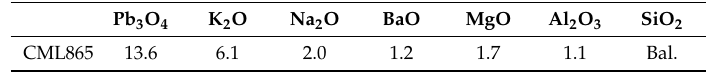
Table 1. The nominal composition of CML865 lead silicate glass (%, mol